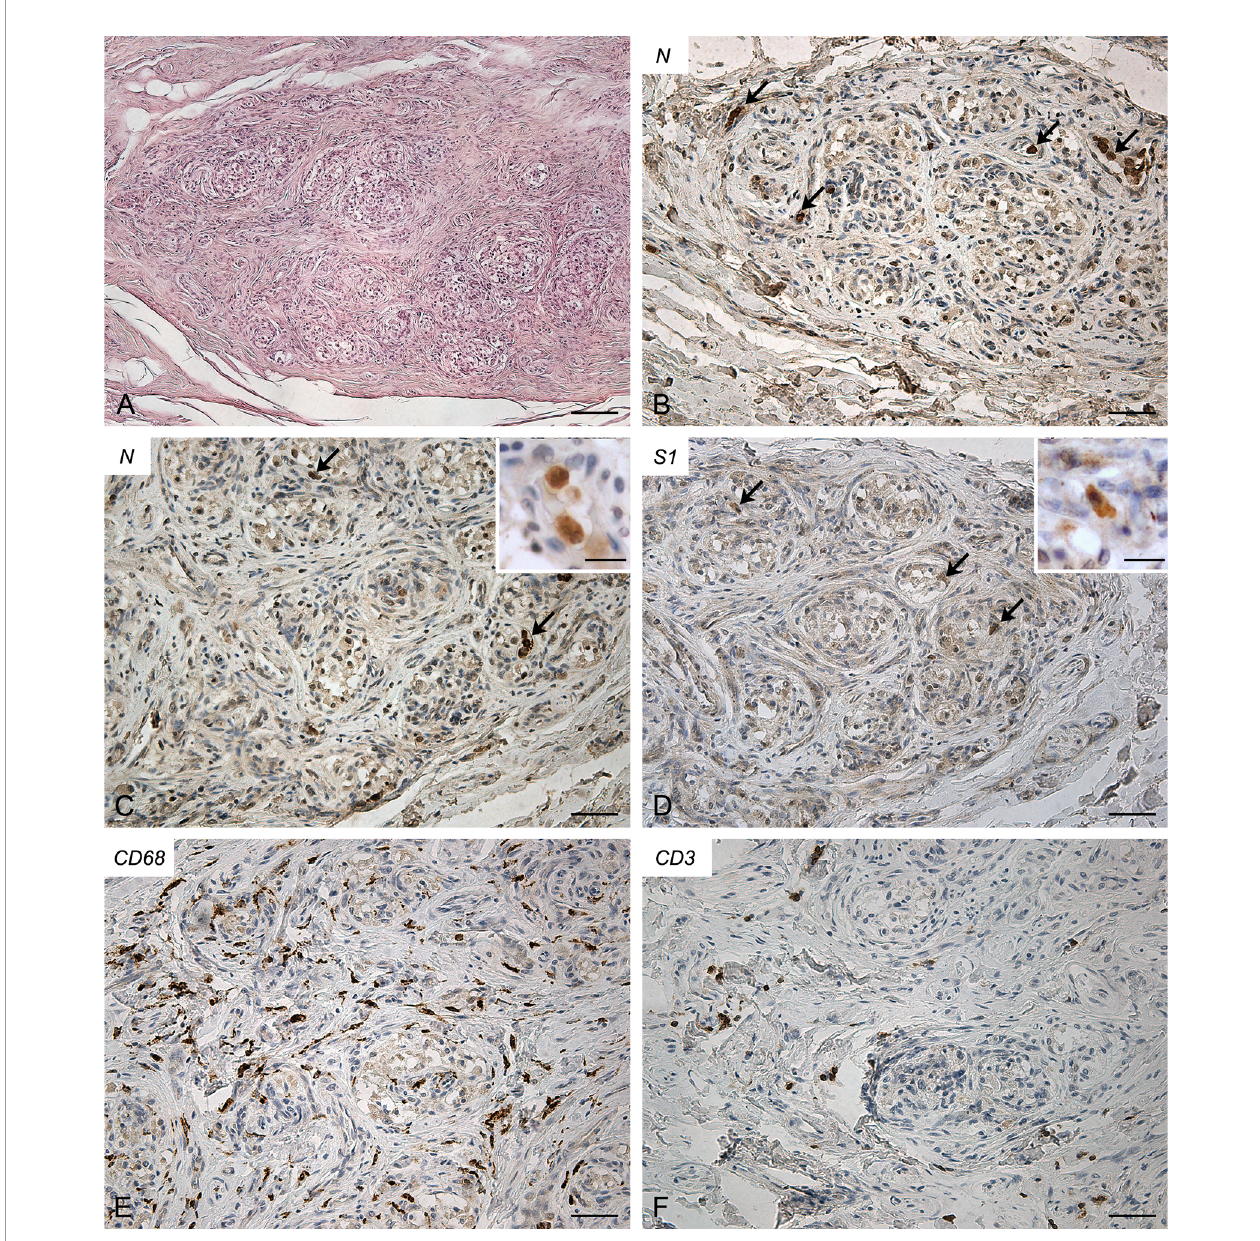
FIGURE 4 | Right carotid body of Case 4 – Haematoxylin-eosin (A) and immunohistochemitries for nucleocapsid ( B-C ; arrows: positive cells), Spike ( D ; arrows: positive cells), CD68 (E) and CD3 (F) . Scale bars: 100 µm (A) ; 50 µm (B – F) . Inserts: high magni fi cation of positive type I cells. Scale Bar: 15